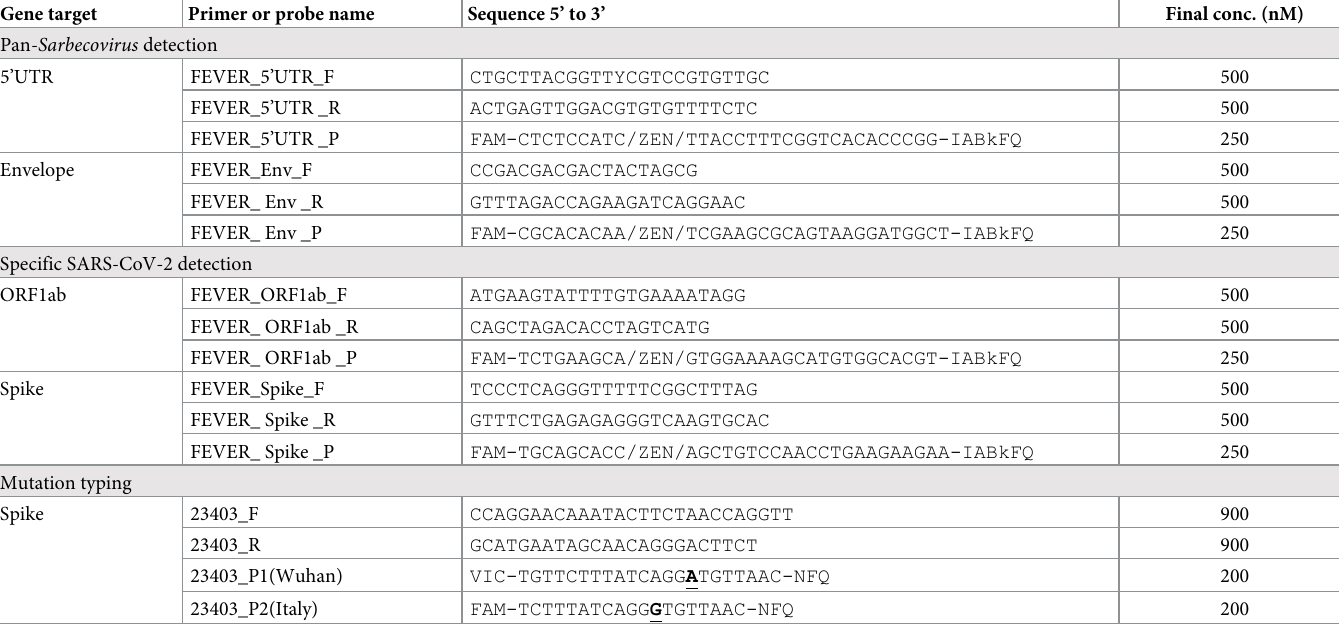
Table 1. FEVER assays for